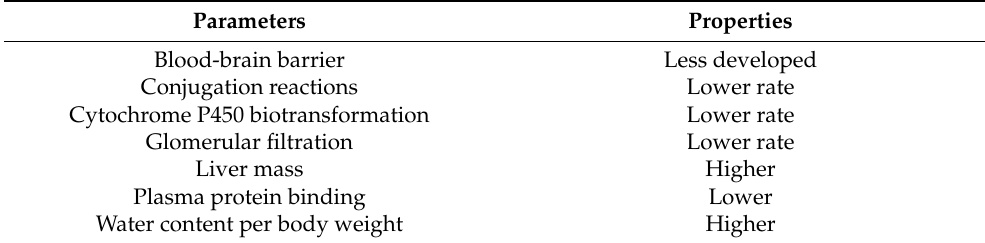
Table 3. Pharmacokinetic parameters in healthy newborns compared with adults